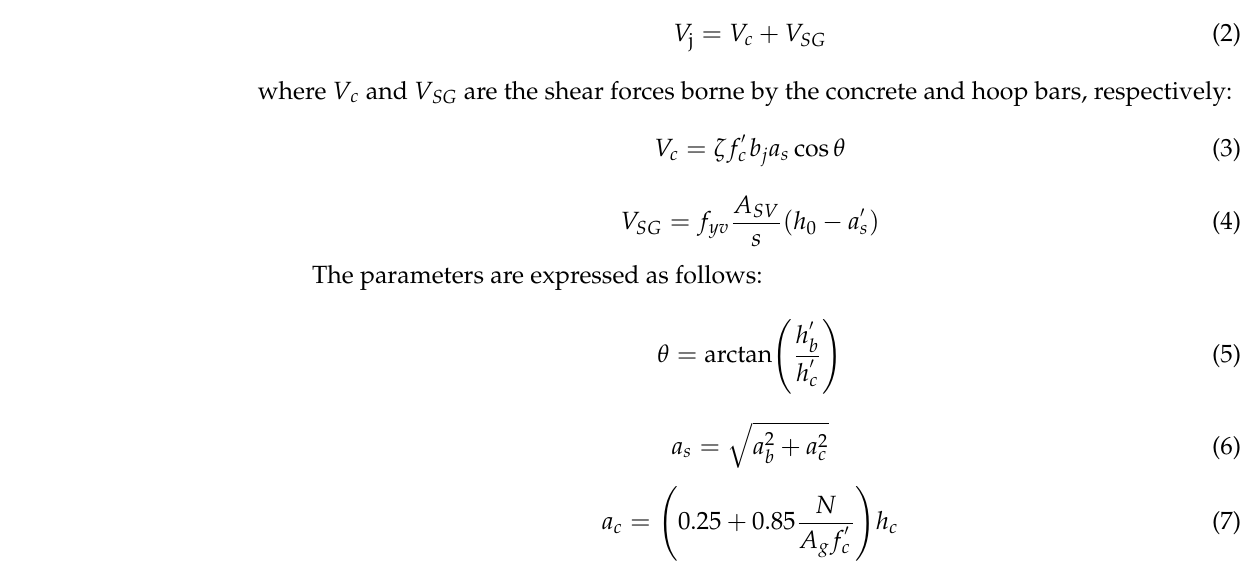
Figure 14. Shear transfer mechanism of joint core region. ( a ) Nodal force model; ( b ) Inclined lever mechanism; ( c ) Truss mechanism.